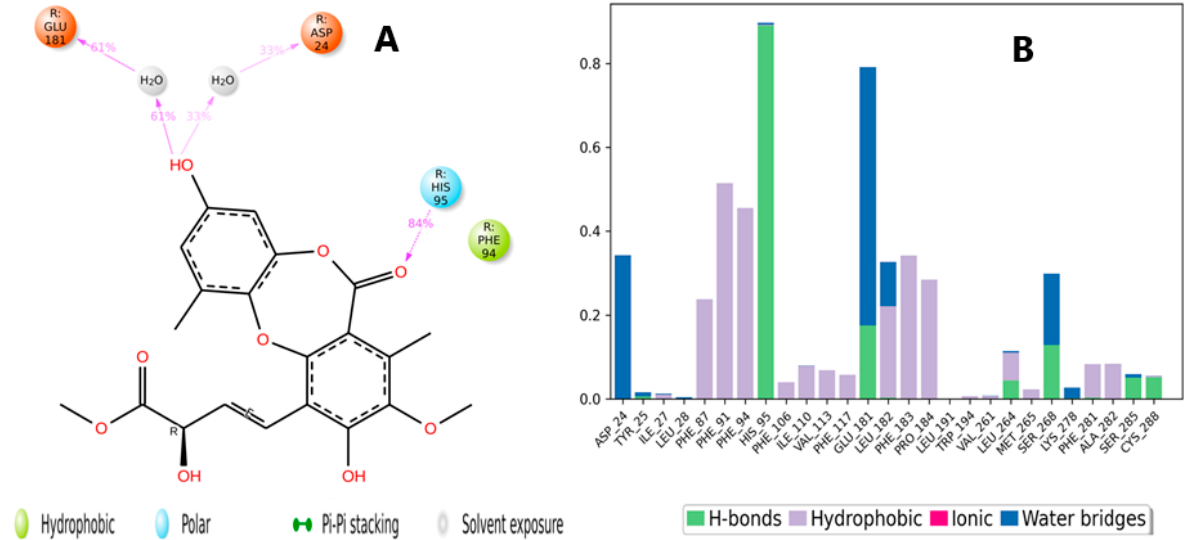
Figure 13. ( A ) Schematic detailed representation of boremexin C ( 161 ) interactions with the CB2 receptor (PDBID: 6KPF) residues, where blue represents the polar residues and green represents the hydrophobic residues. ( B ) Normalized stacked bar chart representing the interaction of the CB2 binding site residues with boremexin C ( 161 ) throughout the simulation: hydrophobic (violet), hydrogen boremexin (green), and water bridges (blue). The stacked bar charts are normalized over the course of the trajectory.